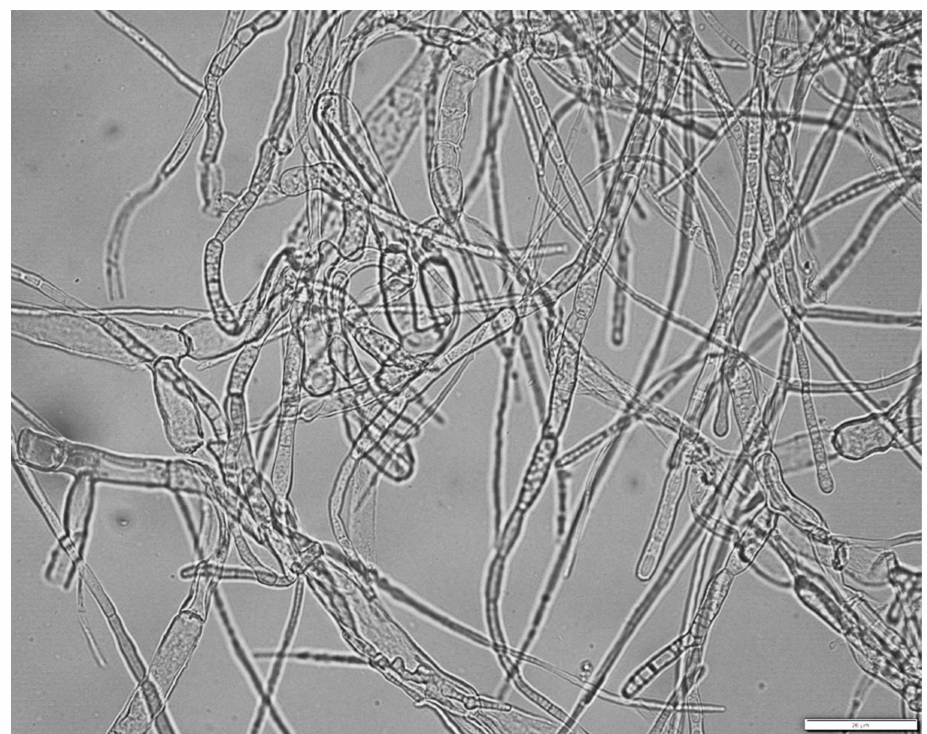
Figure 2. Mycelial filamentous hyphae developed inside the biomass of Hericium erinaceus (Olympus BX43, Hamburg, Germany). Scale bar: 20 µ